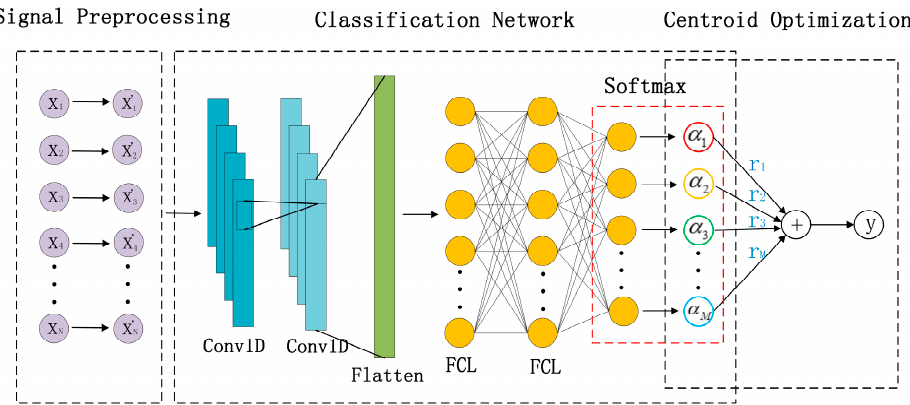
Figure 1. Structure of Centroid Optimization of Deep Neural Network Classification (CO-DNNC) .